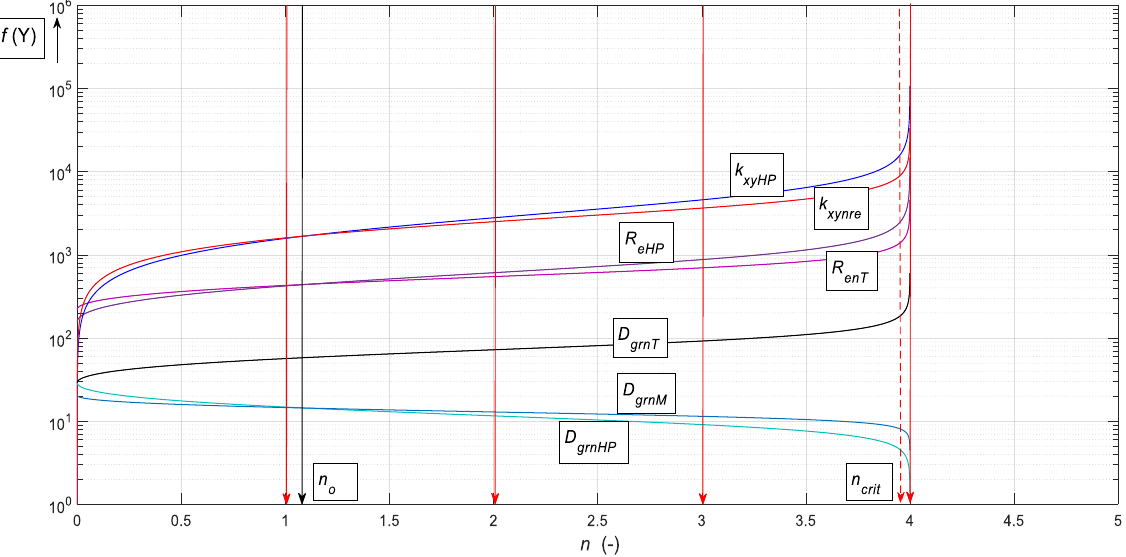
Figure 18. Verification comparison for the specific case of our experiment and newly presented theories according to the Hall–Petch relation.